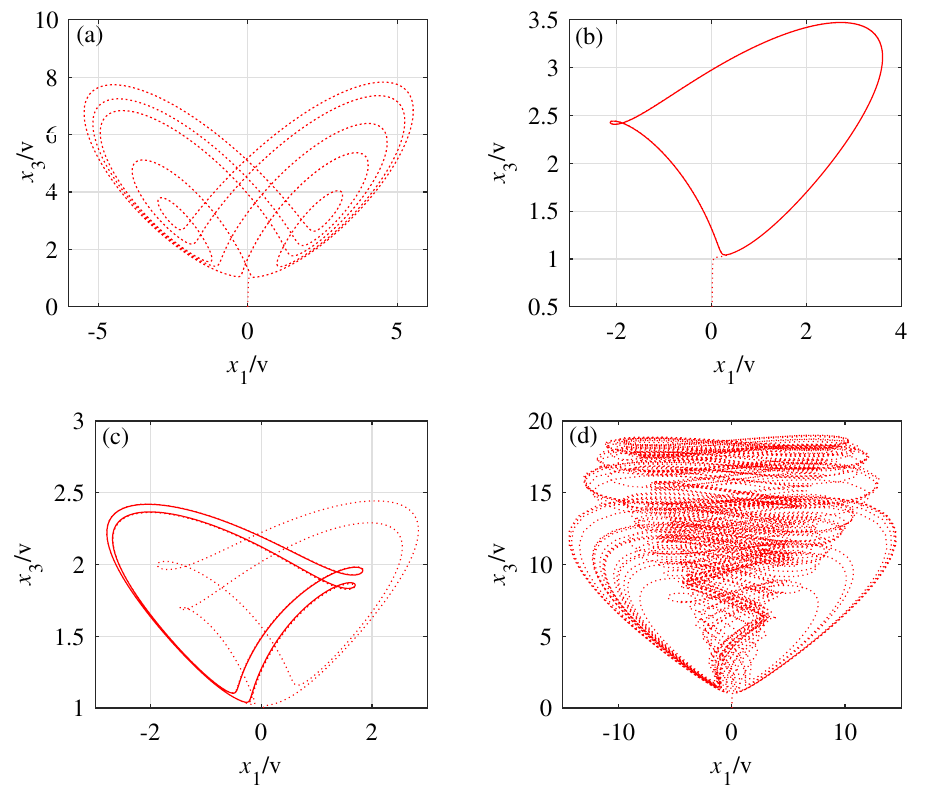
i k ( 3 ) = ( 3 ) = 1 , the circuit simulation x x 1 3 plane. ( c ) − x x i k 1 3 plane. ( d ) When ( 1 ) = ( 1 ) + 1 = 2 , the −